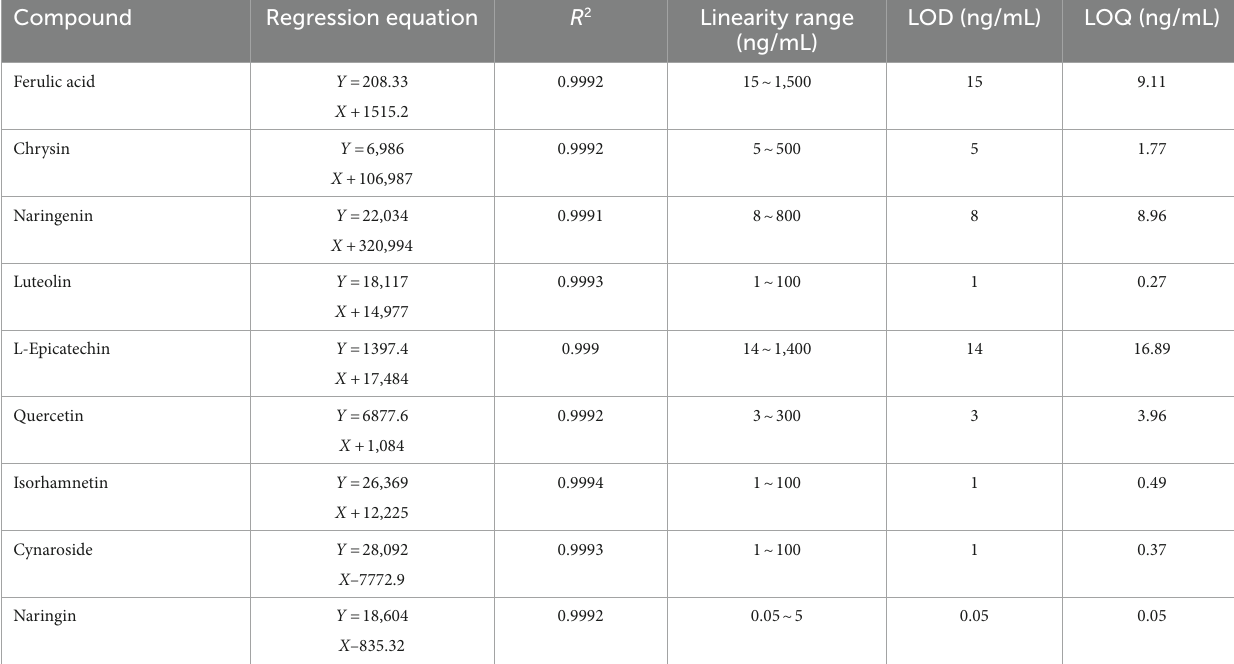
TABLE 2 Linear regression date of nine components.